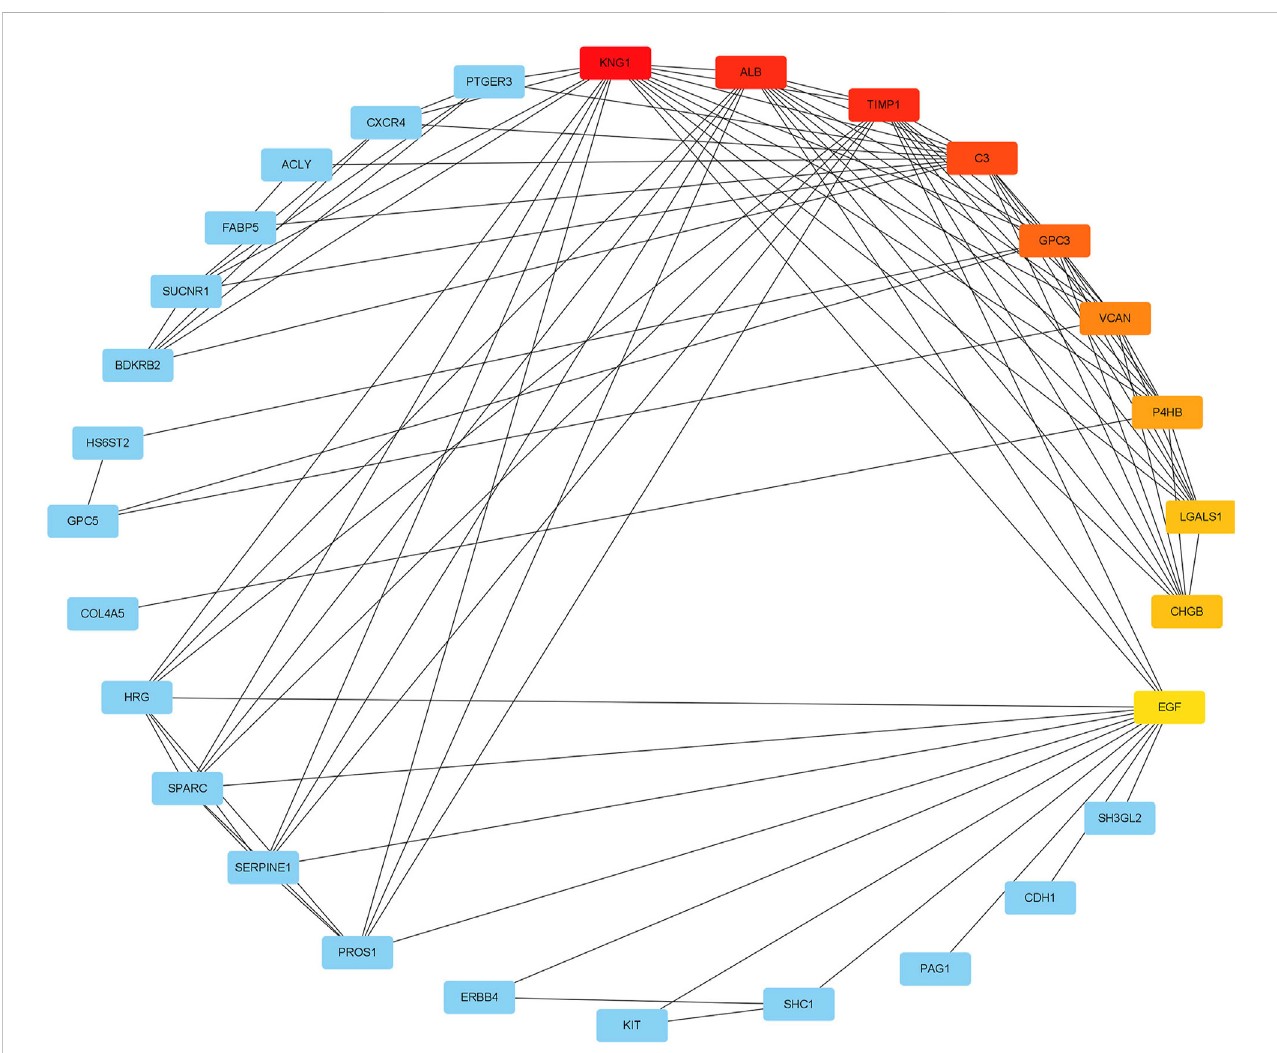
FIGURE 6 The maximal clique centrality (MCC) algorithm was used to identify the hub genes in PPI networks. The edges represented the connection between proteins and proteins. The red nodes represented the genes with high MCC scores, while the yellow node represented the genes with low MCC